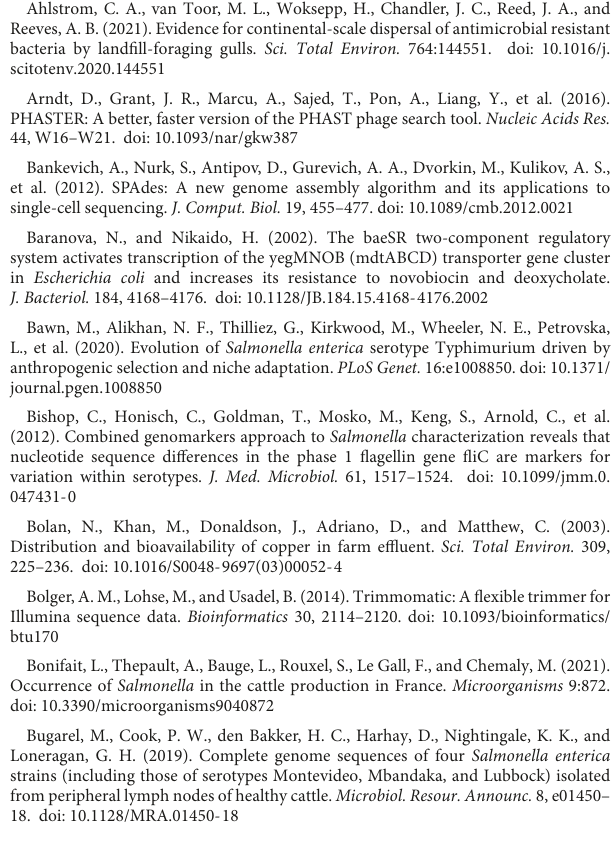
SUPPLEMENTARYFIGURE1 French Salmonella Network data. Salmonella Mbandaka data from the French Salmonella Network database of the Food Safety Laboratory of the French Agency for Food, Environmental and Occupational Health and Safety (ANSES). (A) Distribution of S . Mbandaka data from 2010 to 2020. (B) Data from Salmonella strains isolated from animals and the poultry and bovine production sectors from 2010 to 2020. In the poultry sector, S . Mbandaka isolates account for 3,950 entries out of 110,591 (3.5%). In the bovine sector, S . Mbandaka isolates account for 1,300 entries out of 17,151 (7.6%). SUPPLEMENTARYFIGURE2 Phylogenetic reconstruction based on core-genome single nucleotide polymorphism substitutions of the 304 S . Mbandaka isolated in France from the bovine and poultry sectors, including strain ID, matrix source, and geographic distribution. The maximum likelihood criterion and the transversional model TVM + F model were applied. Salmonella Mbandaka SA20026234 was used as the reference complete genome. In all, 12 groups were identified and are highlighted in different colors. Bootstraps comprised between 80 and 100% are shown as triangles at the node’s